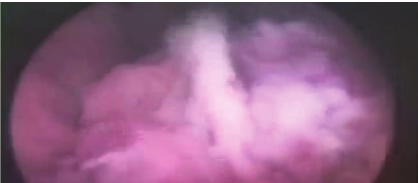
Figure 1: Cystoscopic view of lesions in the neobladder depicting tumors with papillary configuration.